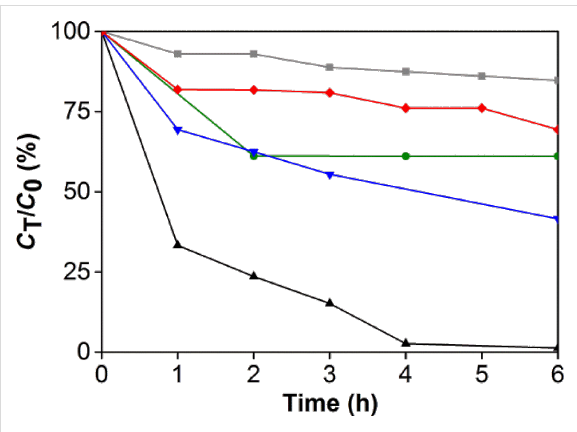
Figure 4: Comparison of RhB concentrations over time at 554 nm, after photocatalytic degradation with mesoporous cerium oxide under light (black) and in the dark with no equilibration (green), 7 nm CeO 2 (red), P25 TiO 2 (blue), and with no catalyst